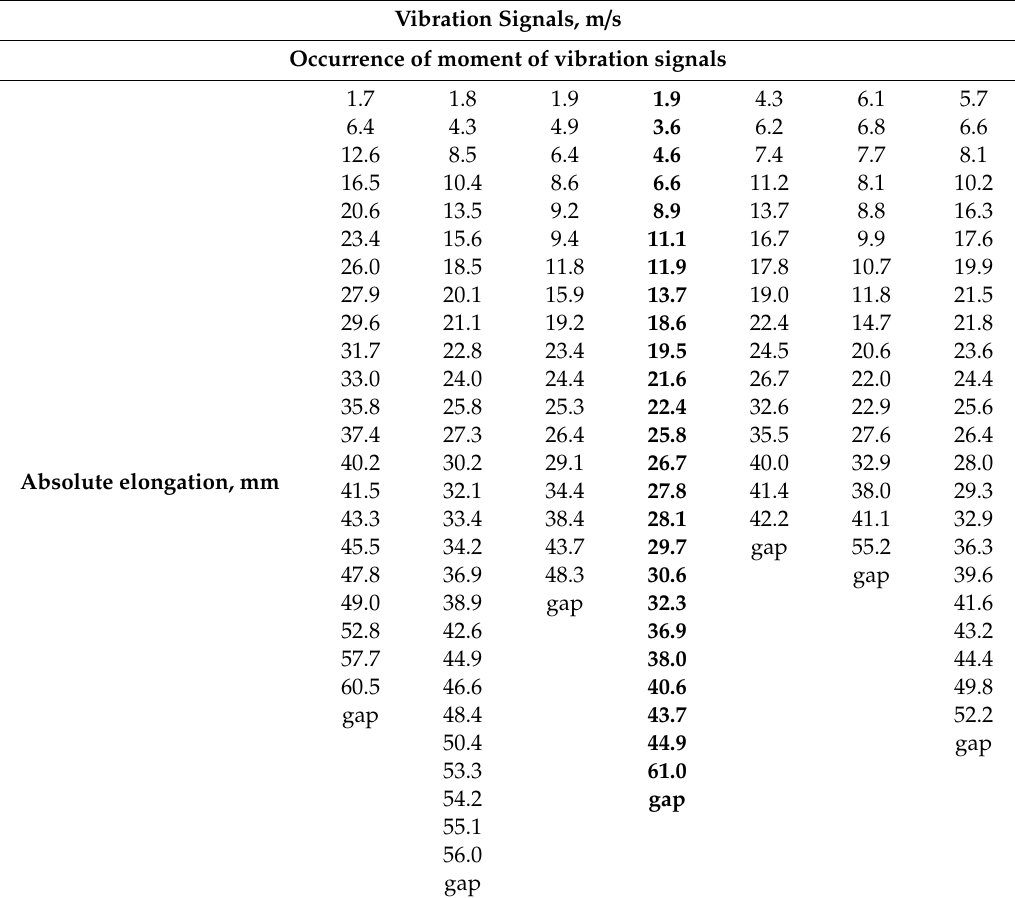
Table 1. Quantitative values of absolute elongation corresponding to the occurrence moments of vibration signals for sheet steel, in